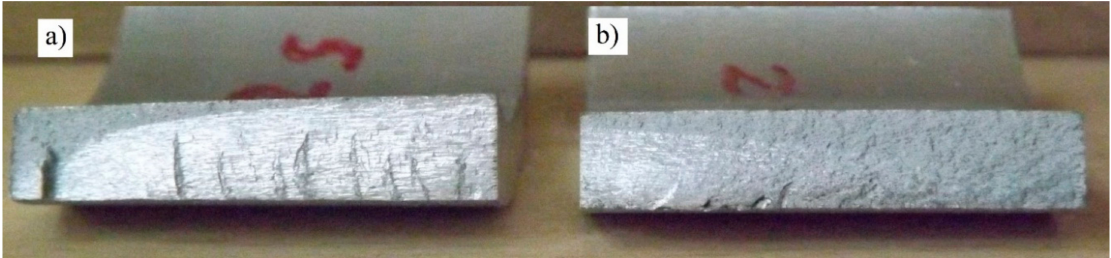
Figure 10. Lip fractures at fatigue failure: ( a ) for Specimen 1 (non-uniform load) at breaking force F z max = 450 N; ( b ) for Specimen 3 (uniform load) at breaking force F z max = 1400